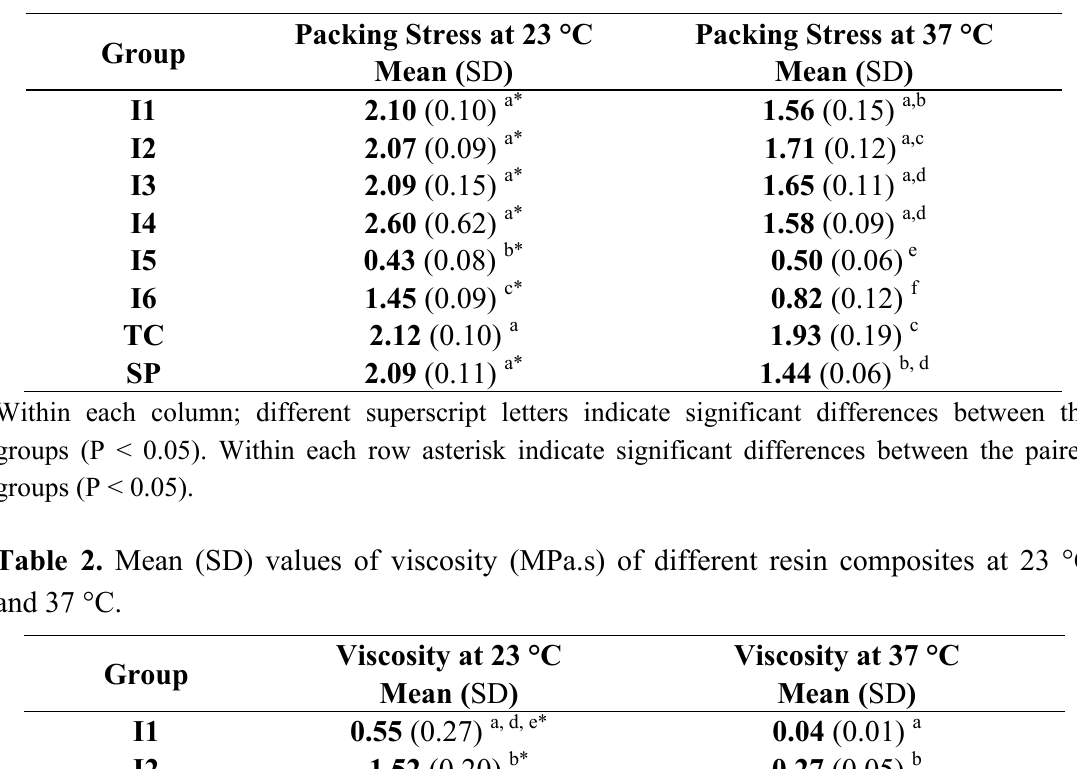
Table 1. Mean (SD) values of packing stress (MPa) of different resin composites at 23 °C and 37 °C.